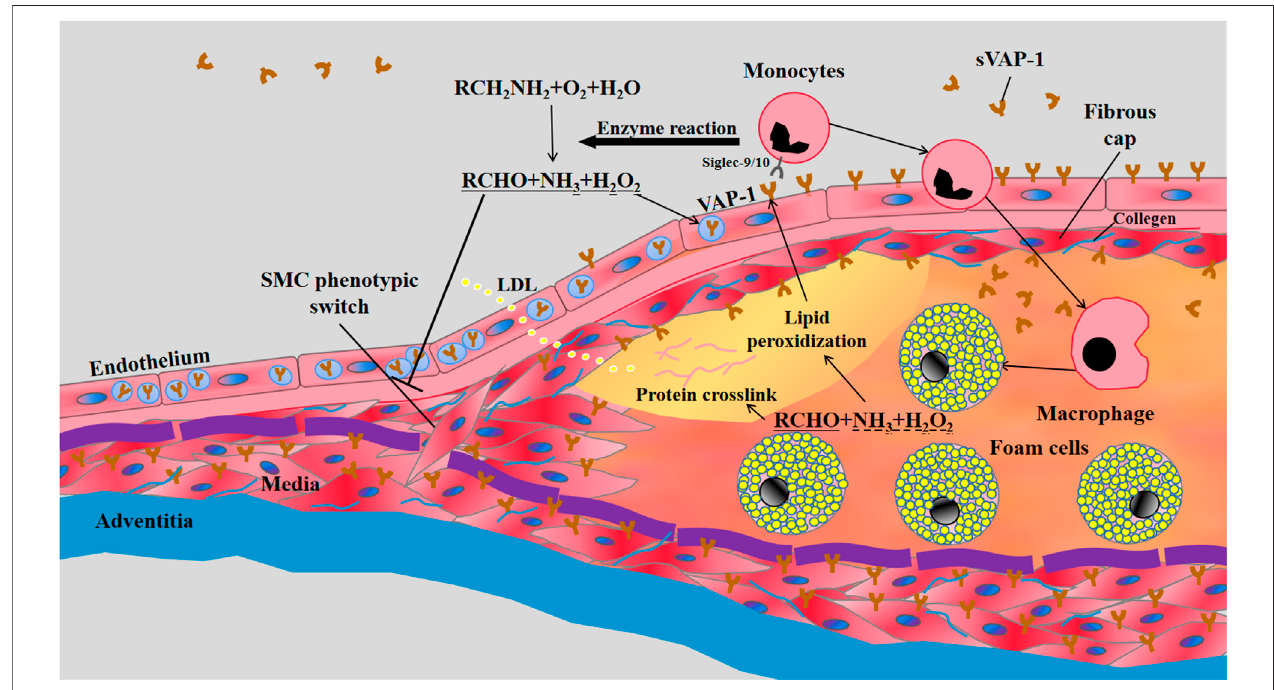
FIGURE1|The involvementofVAP-1inatherosclerosis .LDLretentionandendothelialdysfunctionaretheessentialinitiators ofatherosclerosis.Thevascular in fl ammation induces the translocation of VAP-1 onto the luminal surface of endothelium, which subsequently interacts with Siglec-9/10 (sialic acid-binding immunoglobulin-like lectin 9/10) to mediate the in fi ltrations of monocytes into atherosclerotic lesions. Meanwhile, enzymatic products of VAP-1, such as H 2 O 2 , may further increase the expression of VAP-1 on endothelium and the subsequent transmigration of monocytes. The in fl ammatory early lesions stimulate the transformation of SMCs in media from the quiescent “ contractile ” phenotype state to the active “ synthetic ” state with increased proliferation, migration, and collagen synthesis.VAP-1 in theplasmamembrane ofSMCsmay inhibittheir phenotypic switch by its enzymatic products and thereby limit the growth of fi brous cap composed of SMCs and collagens. VAP-1 thus represents a pathological factor for plaque instability characterized by thin fi brous cap overlying a large lipid core rich in mon/ macrophage-derived foam cells.